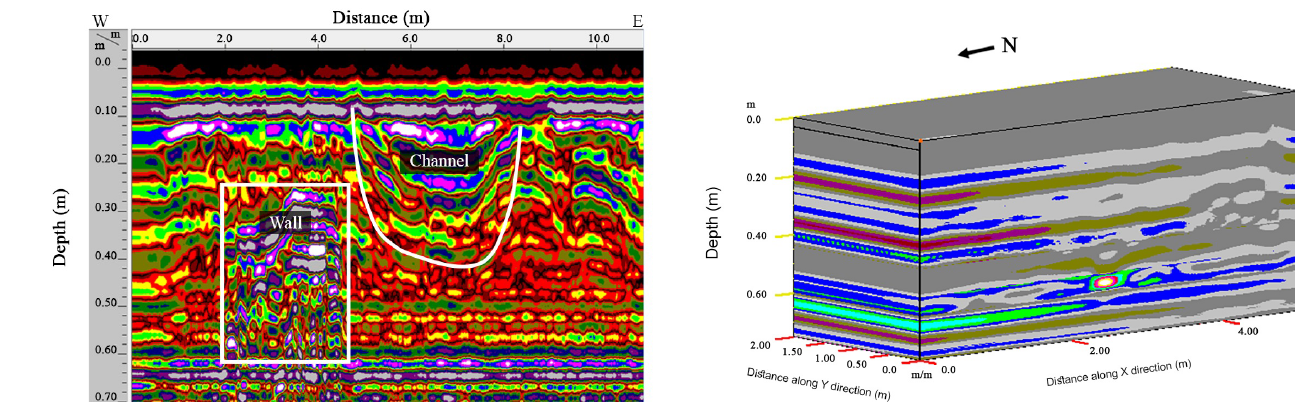
Figure 8. A part of 900MHz antennae radargram along profile 1 immediately adjacent to excavated pottery pipe. The hyperbolic- shaped anomaly at distance 2.5 and 0.55m deep shows the exten- sion location of the buried pottery pipe.